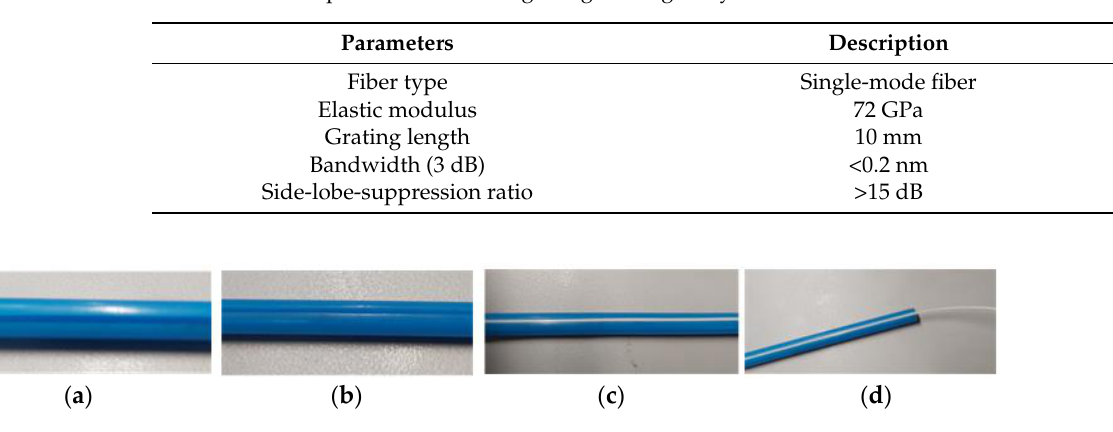
Table 3. Detailed parameters of fiber-grating sensing arrays.